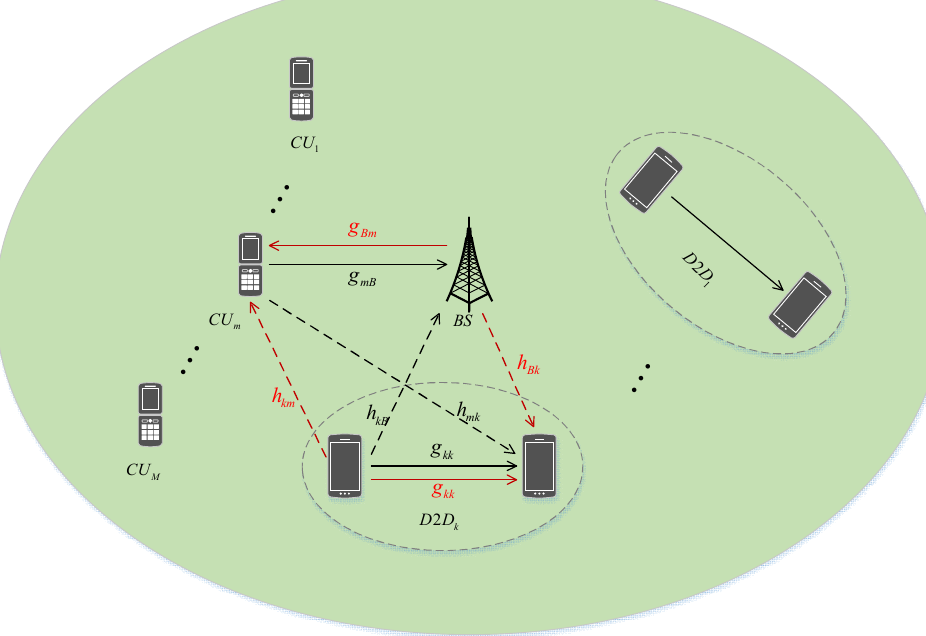
Figure 1. System model for device-to-device (D2D) communications system.